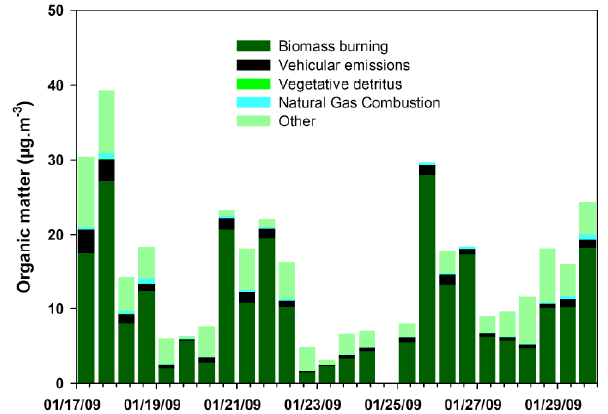
Figure 4 Fig. 4. Source contributions to ambient organic matter (OM) de- termined by the CMB modelling study (sampling intervals: 06:00– 18:00 and